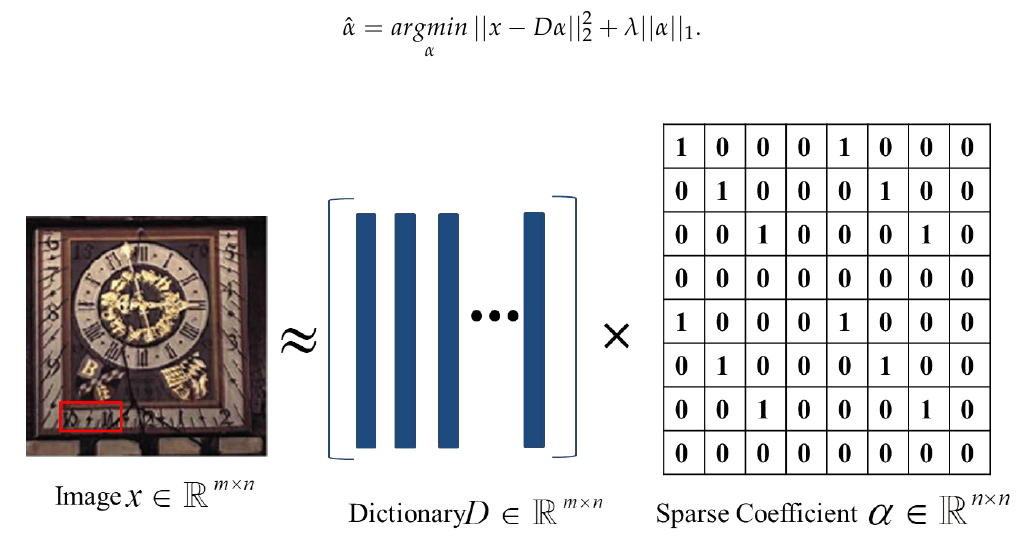
Figure 4. Sparse